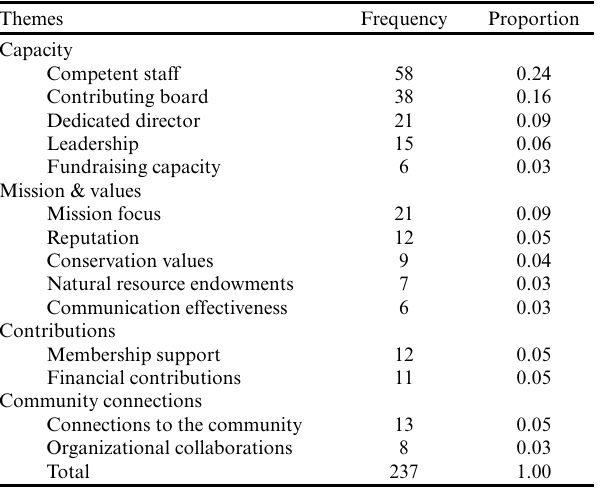
Table 4 . Factors contributing most to a land trust’s success, by theme and subthemes (n = 91).